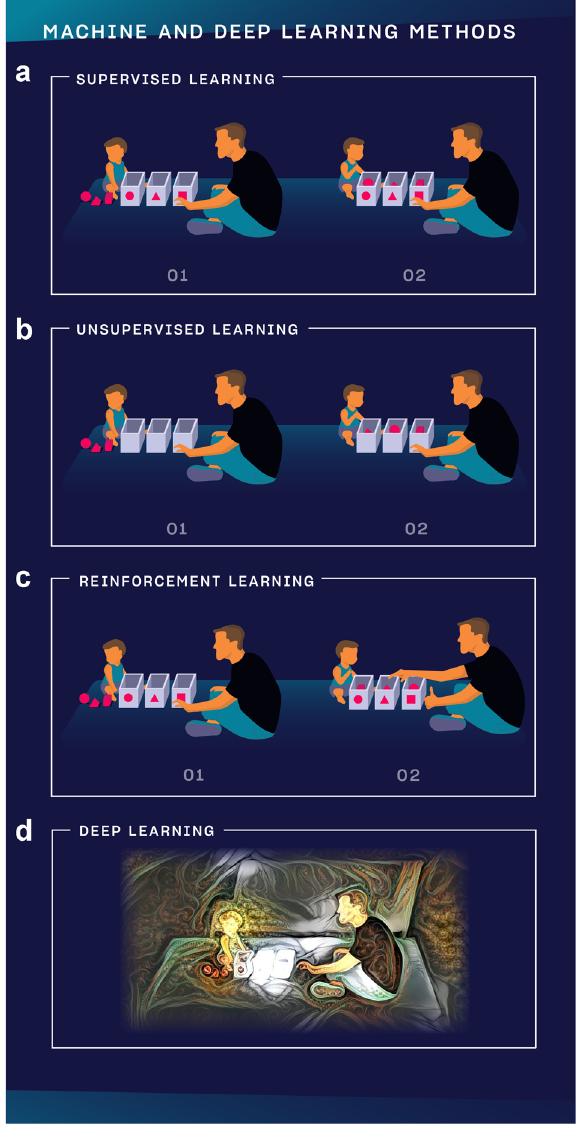
Fig. 3 Visual guide to machine and deep learning subtypes. a In supervised learning, the teacher (developer) knows what he wants to teach to the child (A.I.), de fi nes the expected answer and the child learns to excel at the task. b In unsupervised learning, the teacher does not in fl uence how the child learns to play but observes the conclusions the child can draw from solving the task. c In reinforcement learning, the teacher knows what he wants to teach to the child but does not de fi ne step-by-step how the child should learn it. Instead, the teacher only gives feedback after the task is completed and asks the child to fi nd out his own strategy using those outcomes the teacher rewarded. d In deep learning, it is possible to analyze vastly more complex data sets from images and videos to a sort of human reasoning. It is multi-layered and could mimic how neural networks in the brain